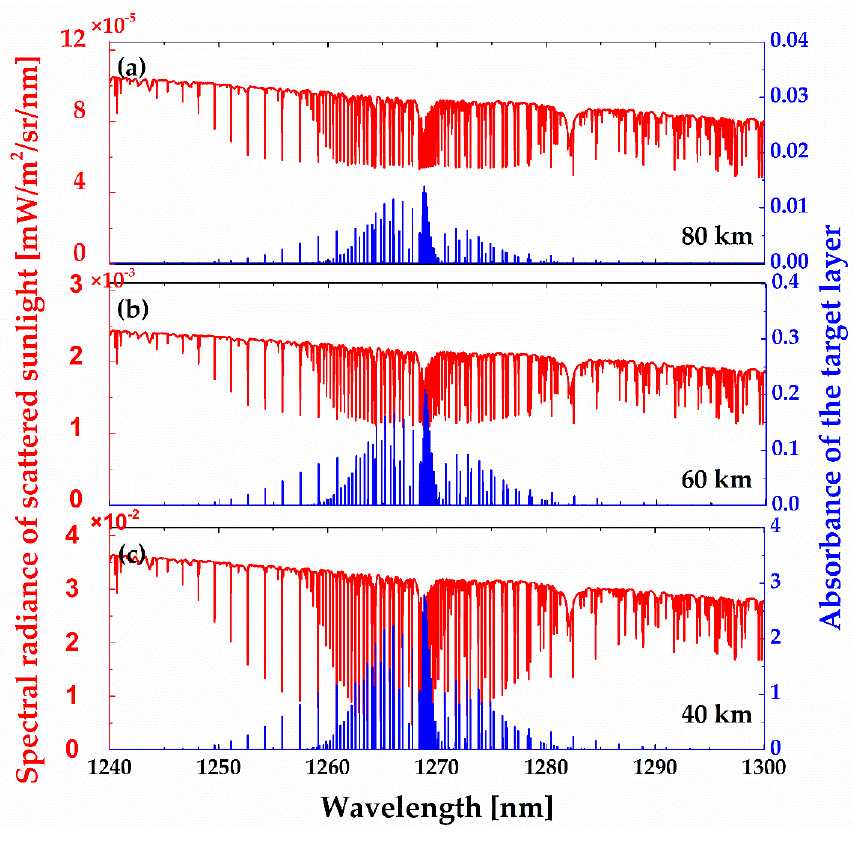
Figure 11. The limb spectral radiance of the scattered sunlight at 1.27 μm and the absorbance of the target layer at different tangent heights.